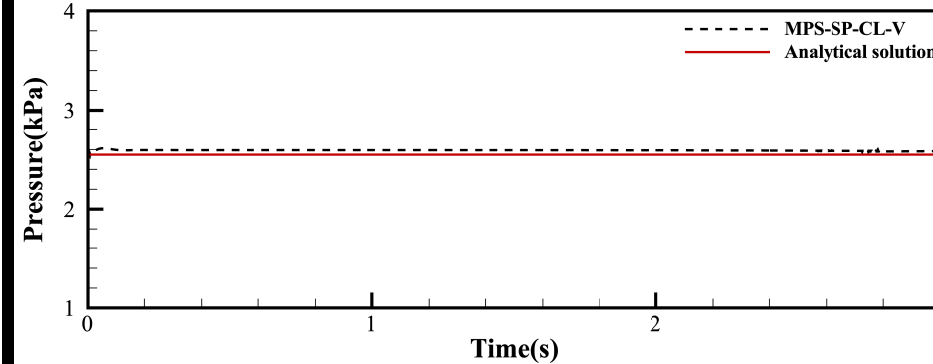
Figure 11. Time histories of the hydrostatic pressure on point S.